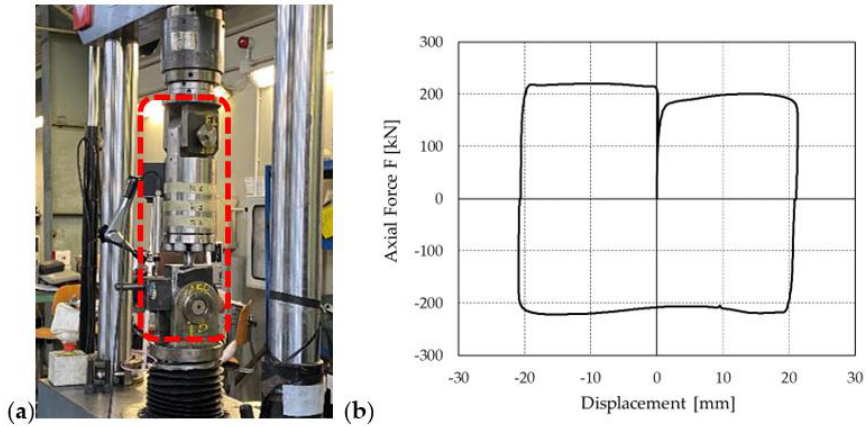
Figure 3. ( a ) The PS-LED prototype (highlighted with a dotted frame) on the testing machine, and ( b ) a typical force – displacement curve of the PS-LED.